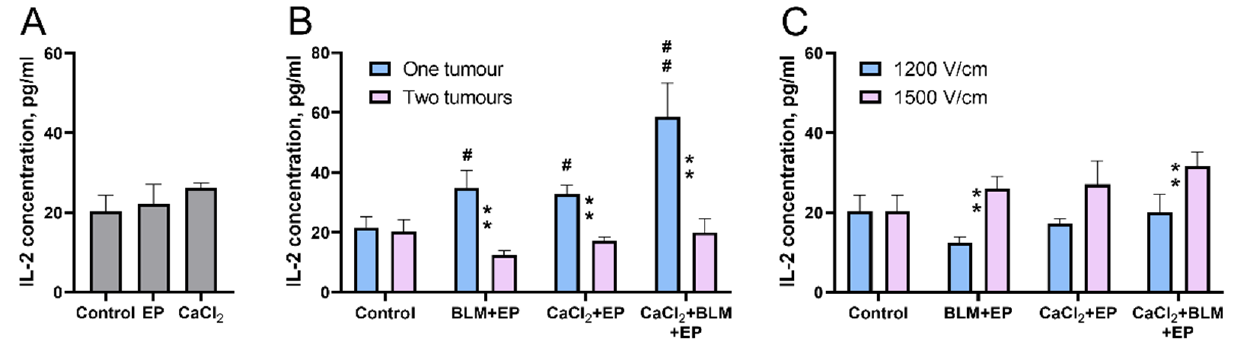
Figure 7. ( A ) IL-2 concentration changes in serum 10 days after tumor treatment using bleomycin electrotransfer, calcium electroporation, or combination of both. ( A ) IL-2 concentration changes after electroporation (1500 V/cm) or CaCl 2 injection. ( B ) IL-2 concentration changes after tumor treatment using calcium electroporation, bleomycin electrotransfer, or combination of both in mice were bearing one or two tumors when 1500 V/cm electric field pulses were used for tumor electroporation. ( C ) IL-2 concentration changes after tumor treatment using calcium electroporation, bleomycin electrotransfer, or combination of both when 1200 or 1500 V/cm strength electric pulses were applied. The serum was collected at 11th day after the treatment. Statistical significance of the differences between experimental groups were evaluated using t -test. ** symbols represent statistical significance ( p < 0.05 and p < 0.01, respectively) of differences between corresponding groups. #, ##, symbols represent statistical significance of differences between individual experimental group compared to the